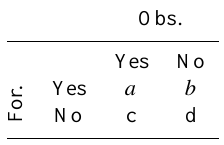
Table 1. 2 × 2 contingency table.